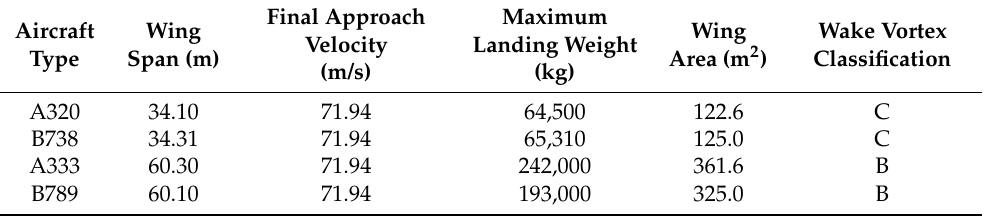
Table 1. Parameters of